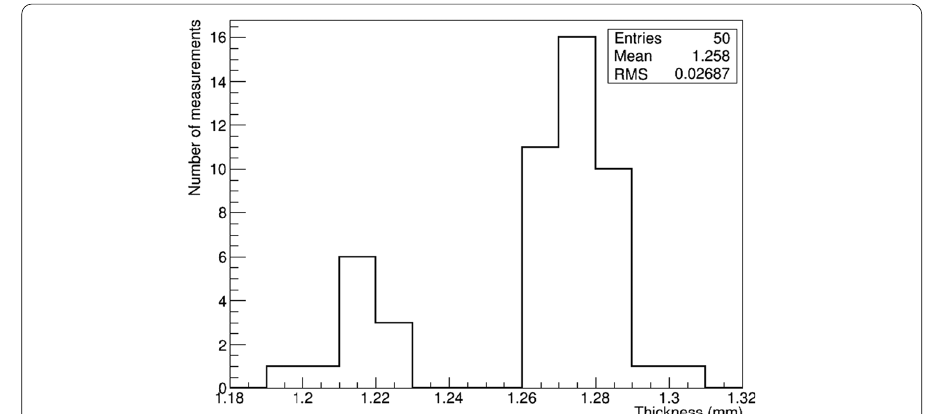
Fig. 11 Distribution of the thickness measured for 10 points over the circumference of five GMP vials